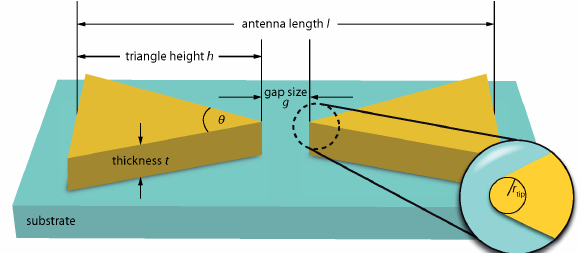
Figure 3: Labeled schematic of one single bow-tie antenna. Not captioned, the angle θ defines the opening of the idealized single, isosceles triangle. Due to the fabrication process, all tips and edges are rounded in actual nanoscopic samples. Most importantly, the rounding of the opposing triangle tips is characterized by the radius of curvature r tip